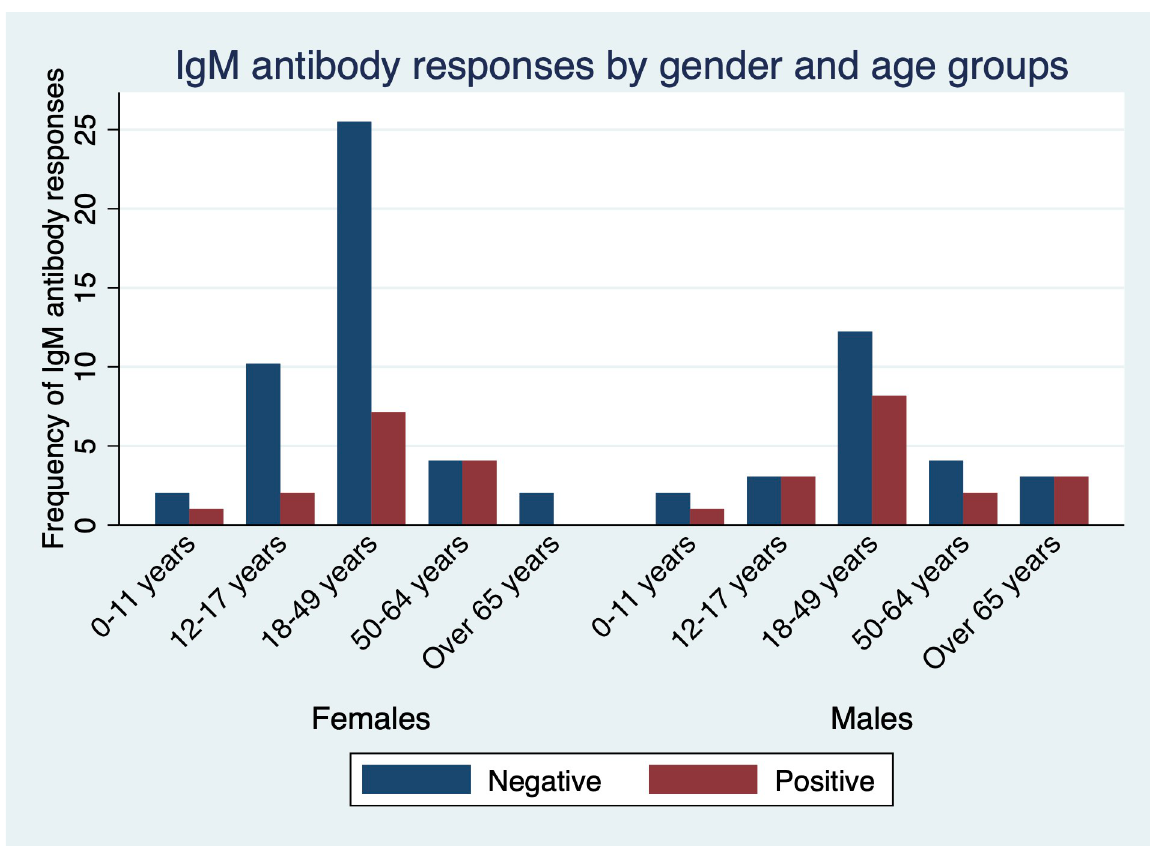
Fig 2. Seroprevalence of infection-induced SARS-CoV-2 IgM antibodies, by gender and age group—Kisumu and Siaya counties, Kenya, December 2021–March 2022.